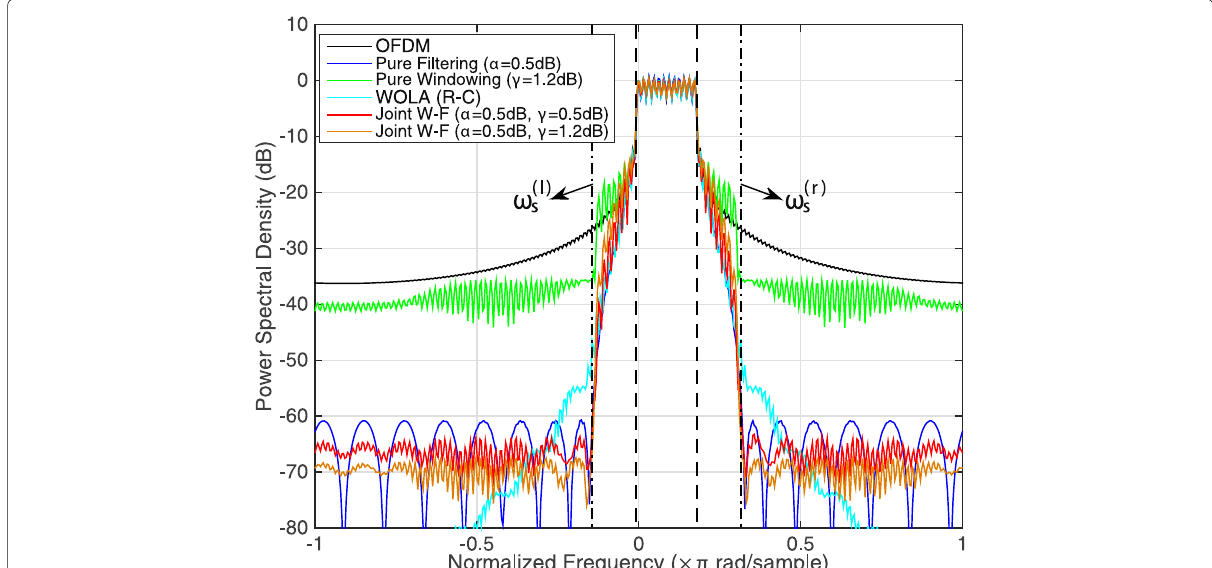
Fig. 6 PSD of various types of waveforms ( η =